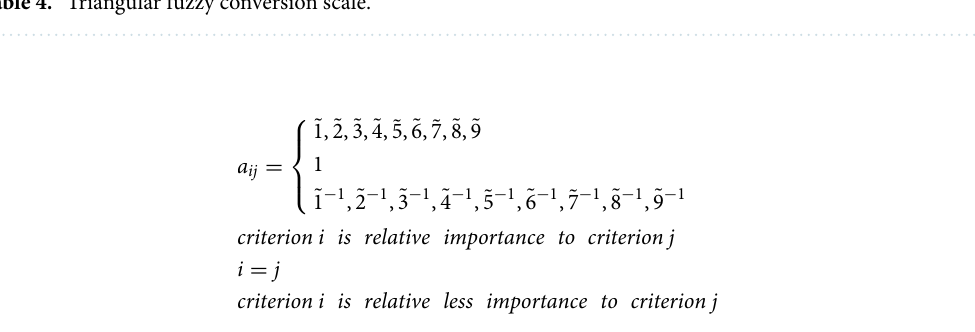
Table 4. Triangular fuzzy conversion